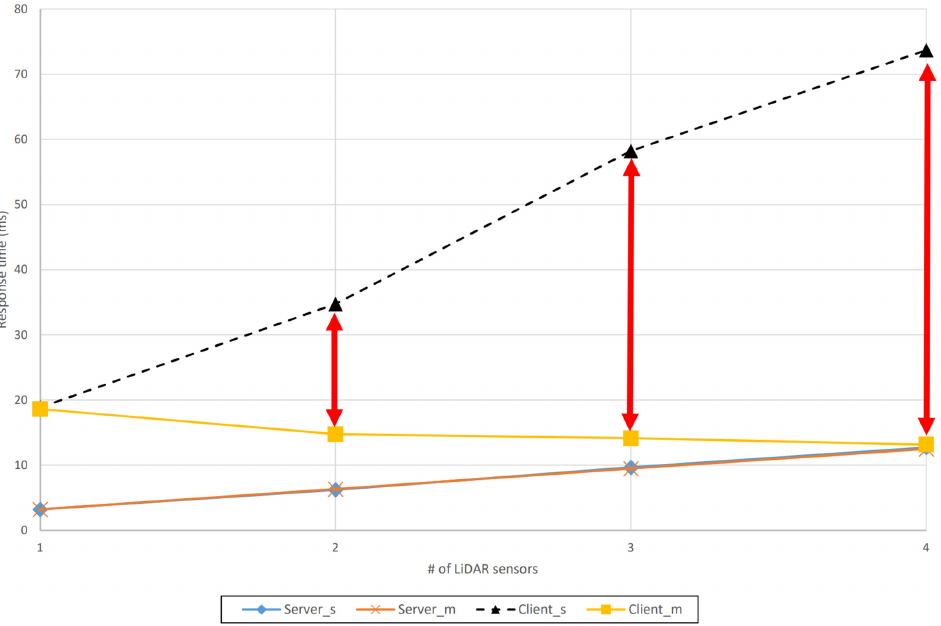
Figure 8. Response time comparison between sequential processing and multiprocessing. Figure 9 represents the response time of the clients when varying from one to four the number of connected LiDAR sensors. As the number of connected LiDAR sensors in-